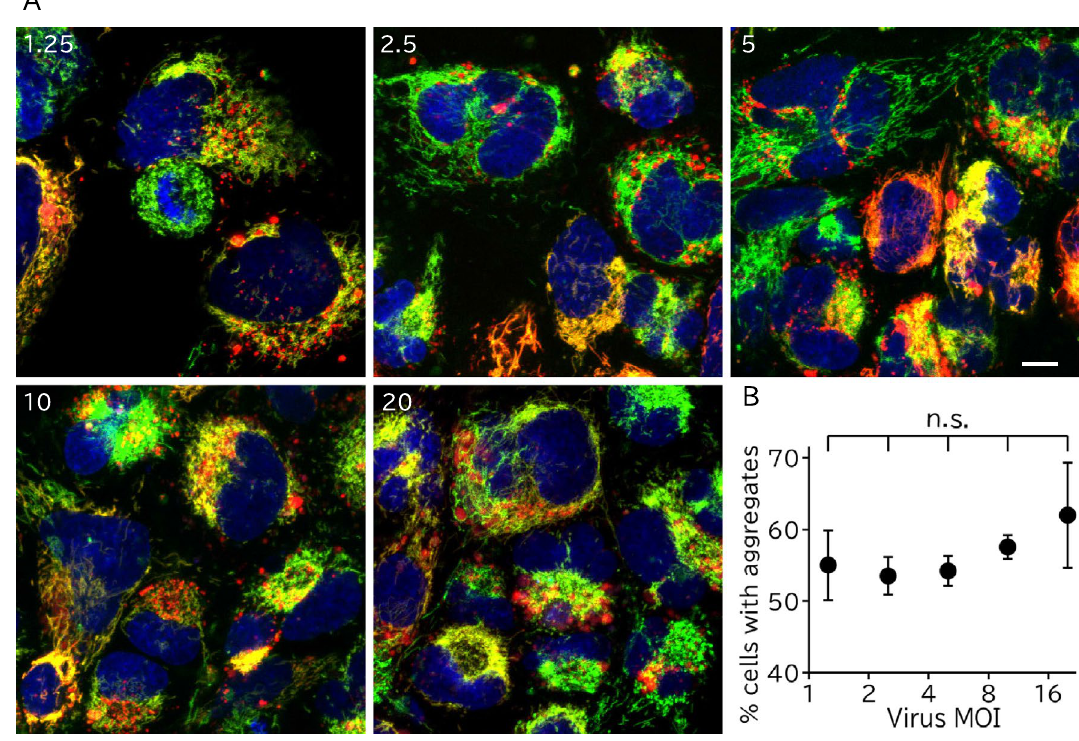
Figure 3. Aggregate formation is not dependent on the virus dose. ( A ) Representative images of iAECs transduced with serially diluted lentivirus containing mitochondria-targeted mCherry (red) stained with MitoTracker Green (green) and Hoechst 33342 (blue). The top-left numbers in the images indicate the virus MOI. Scale bar = 10 µm. ( B ) The proportion of cells with aggregates is plotted against the virus titer. Data are shown as the mean ± SD, n = 3 biological replicates. Each replicate included at least 80 cells from 7 visual fields. n.s.: not significant (p > 0.05); Tukey’s HSD